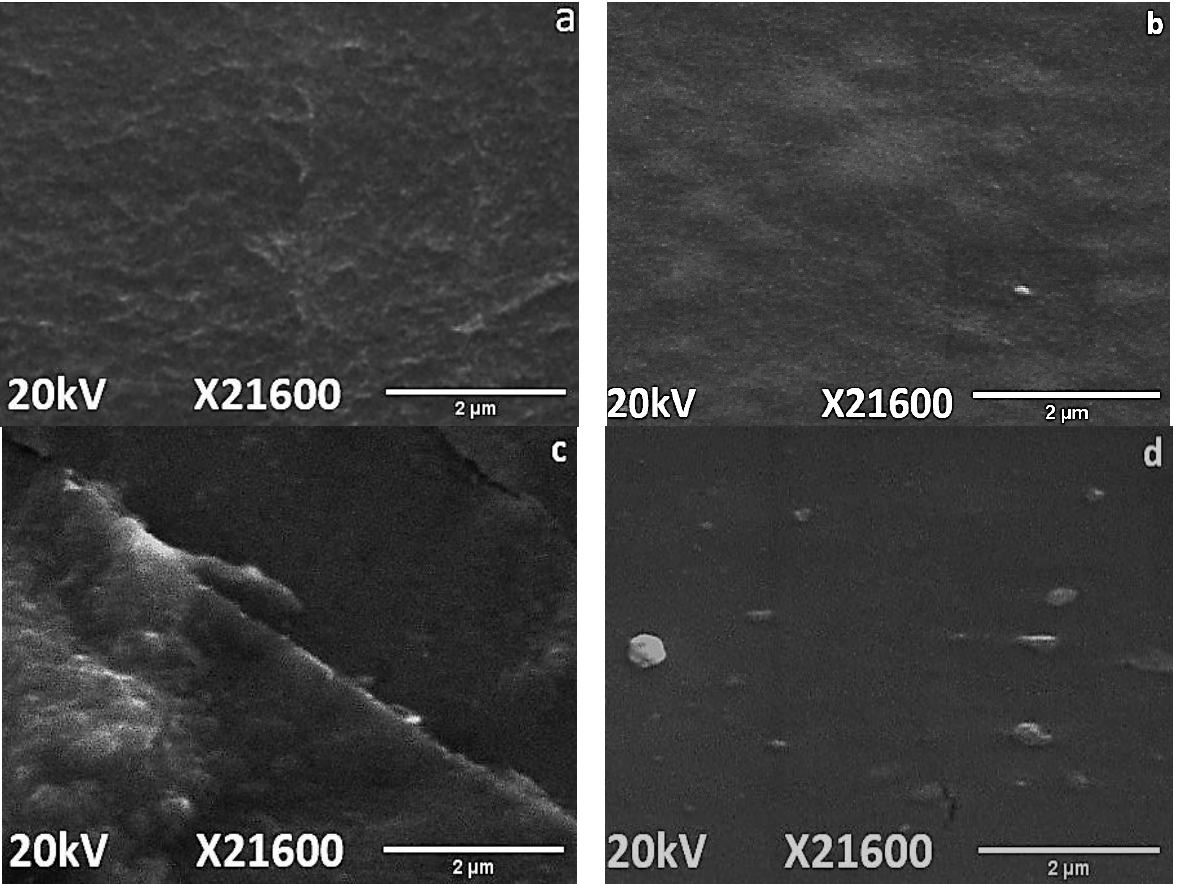
Figure 10. SEM images of virgin ( a ) nSiR ( b ) SMC 15 ( c ) SNC 2.5 and ( d ) SNC 5.